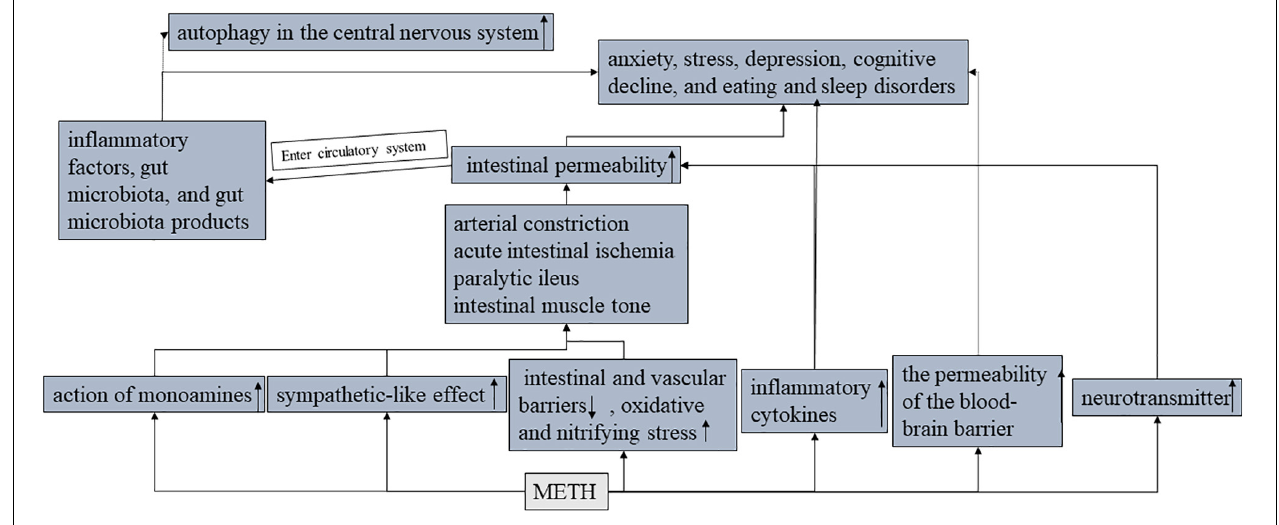
FIGURE 5 | The effects of METH on the gut-brain